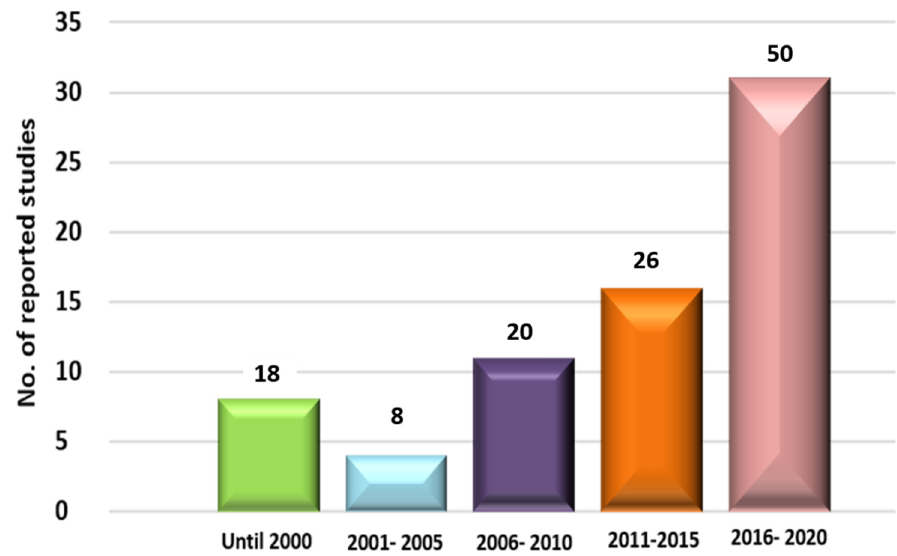
Figure 1. Secondary metabolites elicited from different Actinomycetes according to the year of pub- lication.